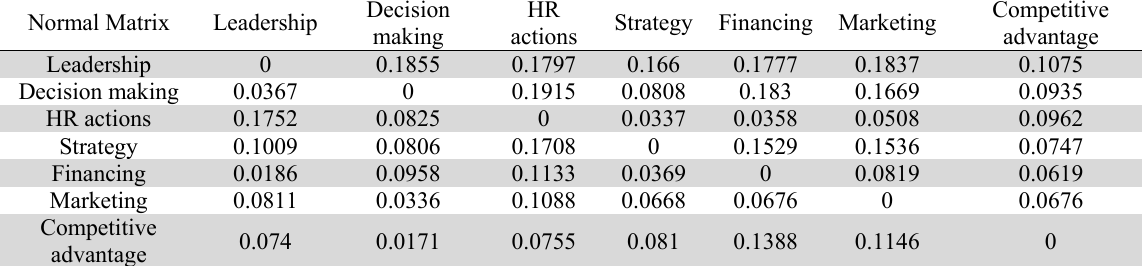
Step 2: Normalization or relative intensity of direct relations Normal